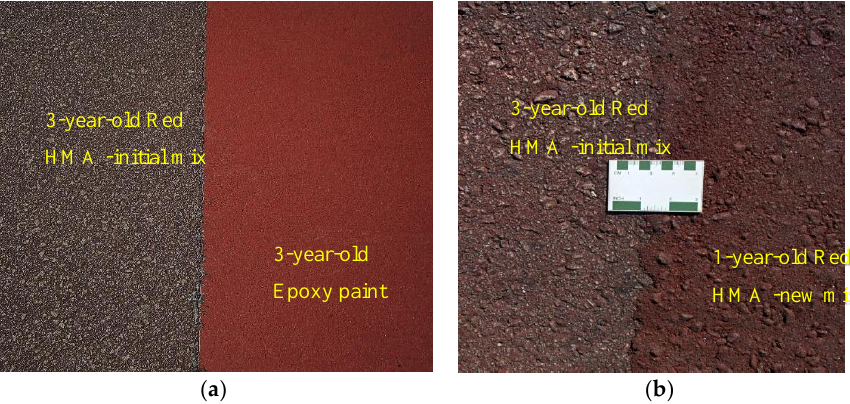
Figure 8. Monitored discoloration caused by oil drips and formation of oil streaks.